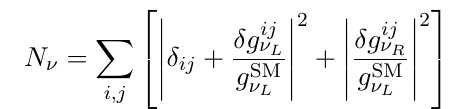
‘ i ‘ j , Z (cid:23) i (cid:23) j and W ! !